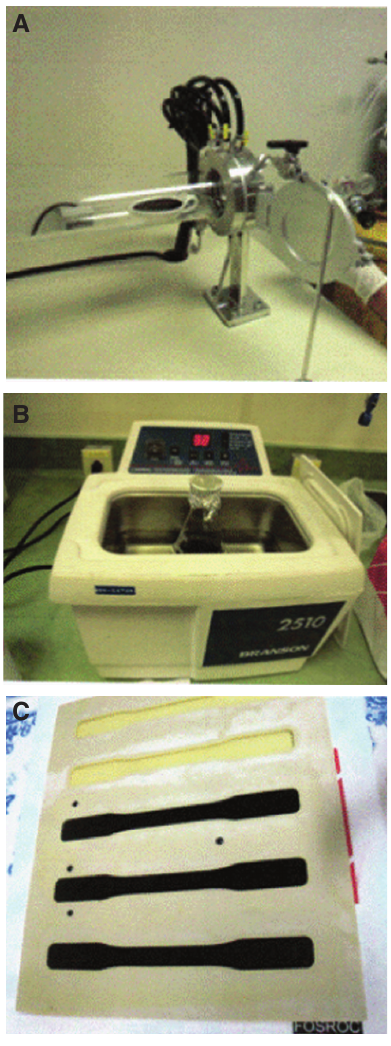
Figure 1 (A) LPCVD machine used in this study. (B) Ultrasonication of the mixture. (C) Molded